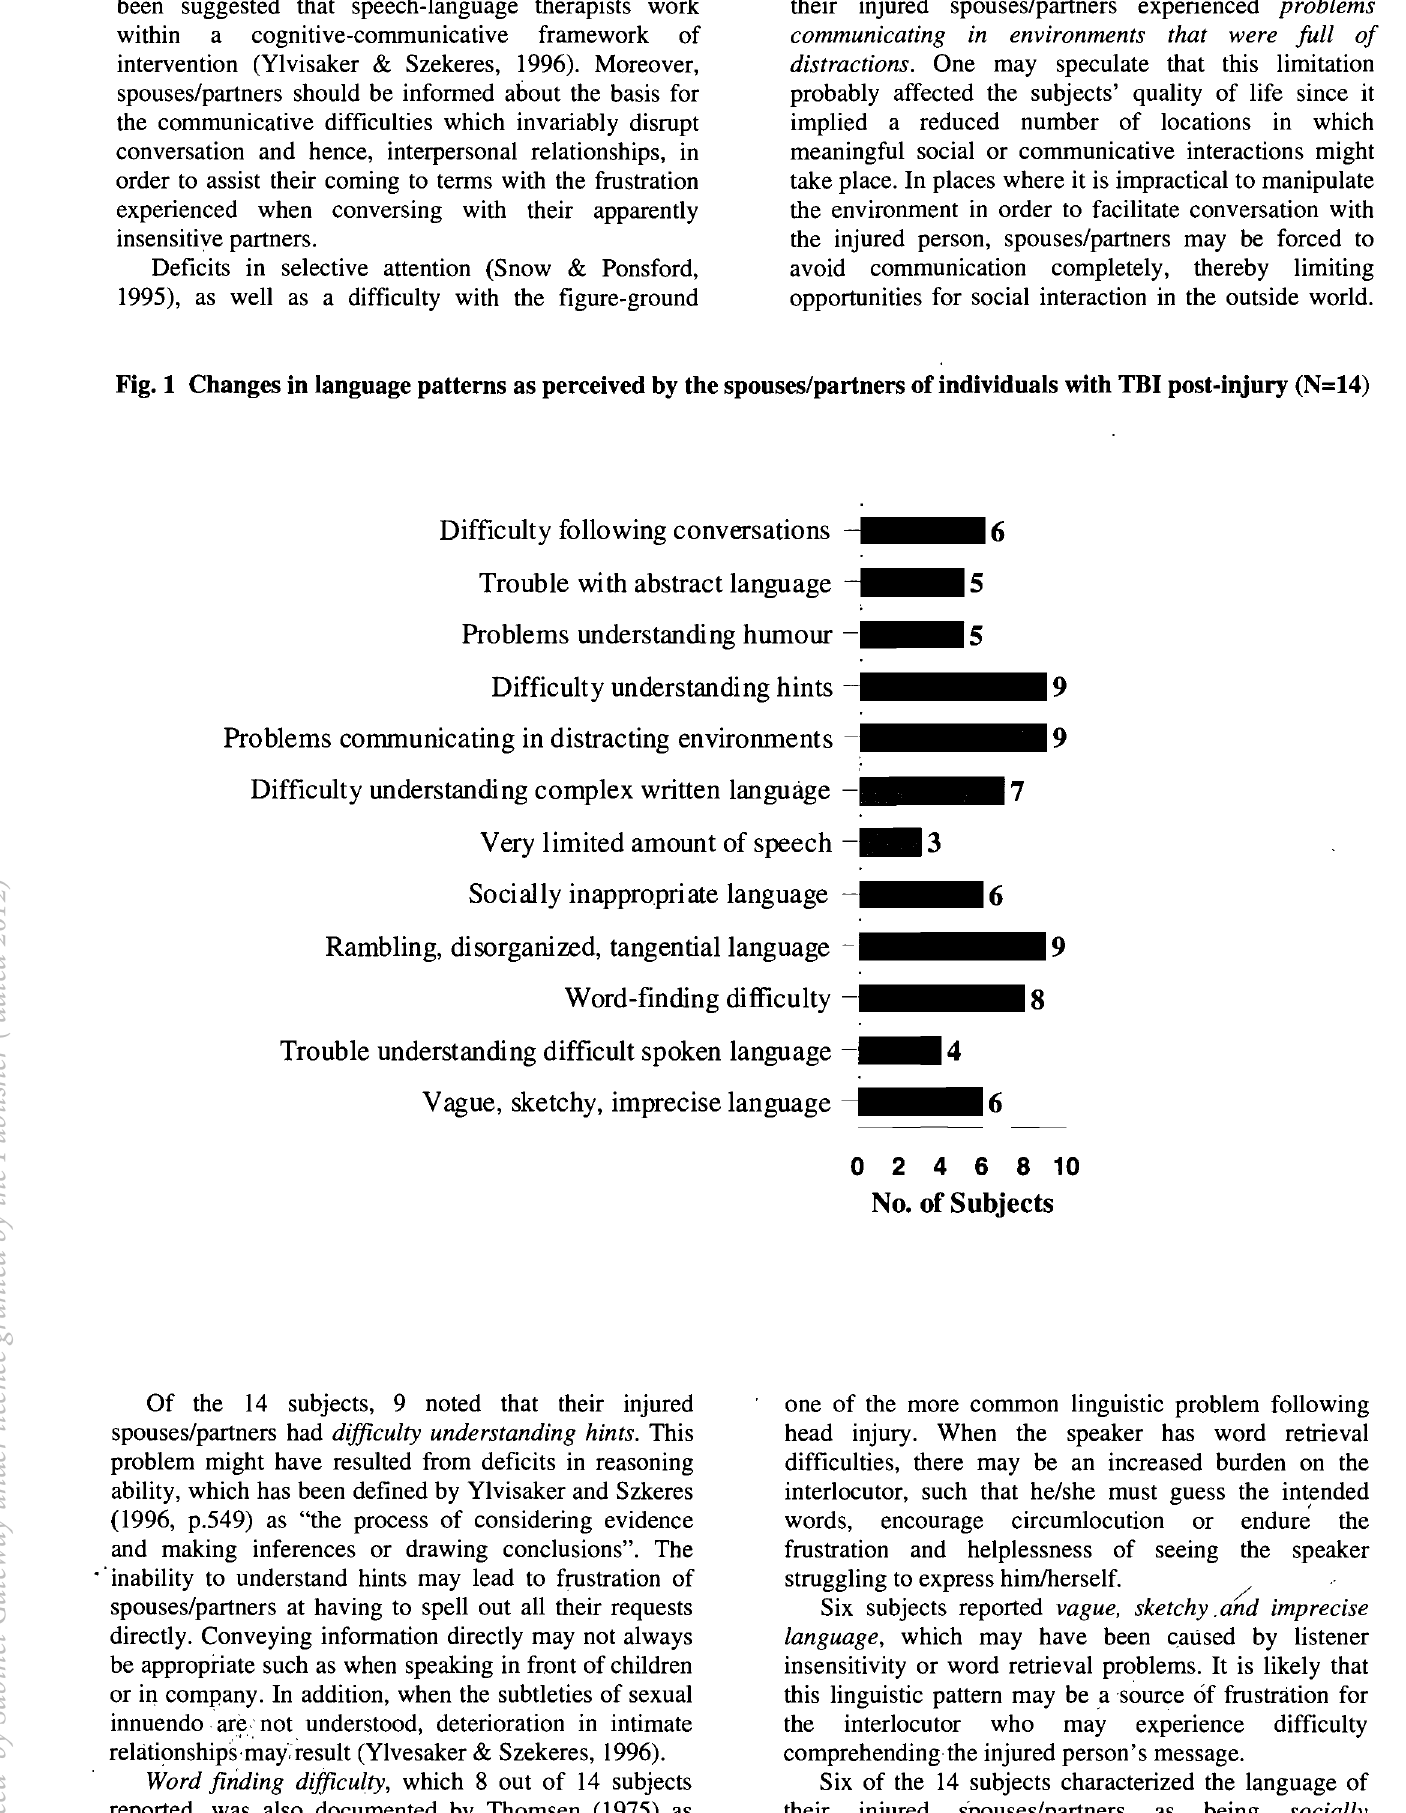
Fig. 1 Changes in language patterns as perceived by the spouses/partners of individuals with TBI post-injury